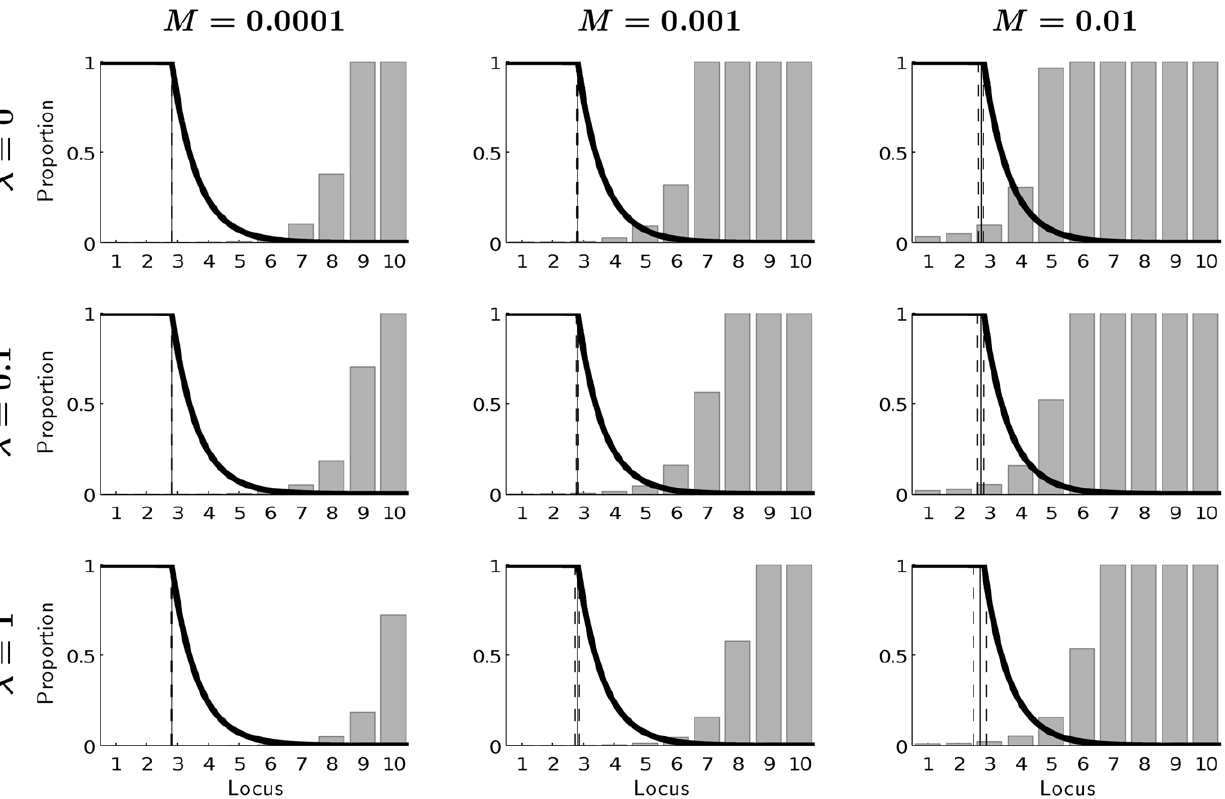
Figure 4. Equilibrium frequencies of mutations in different loci for background mortality m e =0.01 and adverse effect of mutations on mortality d =0.001 under different mutation rates M and different effects of mutations on production rate l . The vertical lines represent mean age at maturity (solid) with standard deviation (dashed). The thick solid line captures the fraction of remaining reproduction, which is proportional to Hamilton’s force of selection.